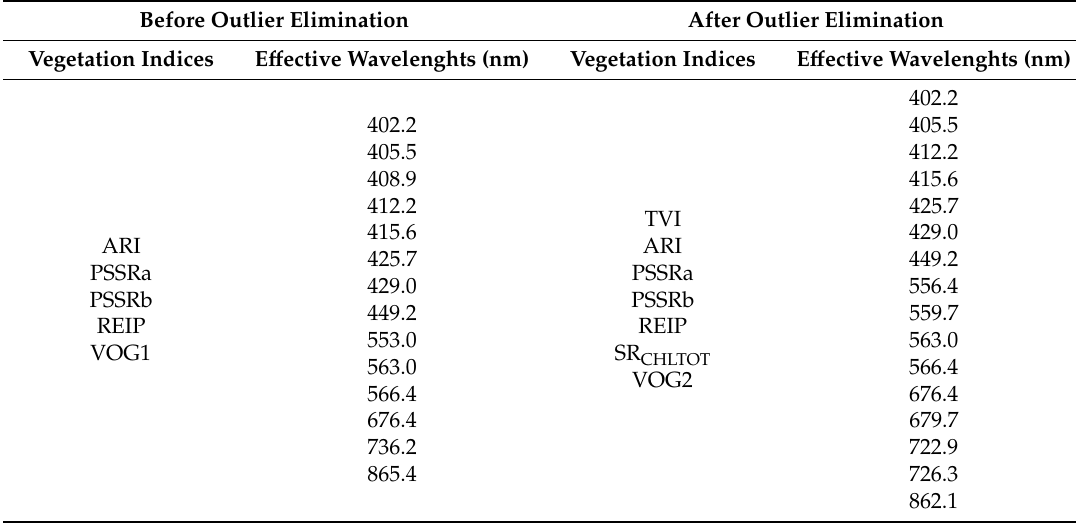
Table 4. Vegetation indices and e ff ective wavelengths that were selected by the NCA algorithm as the input features for the selected classifiers before and after the outlier elimination.